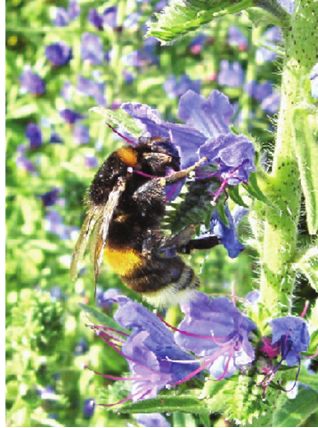
Figure 6: Newly emerged B. muscorum queen feeding on Betonica o ffi cinalis inflorescence.